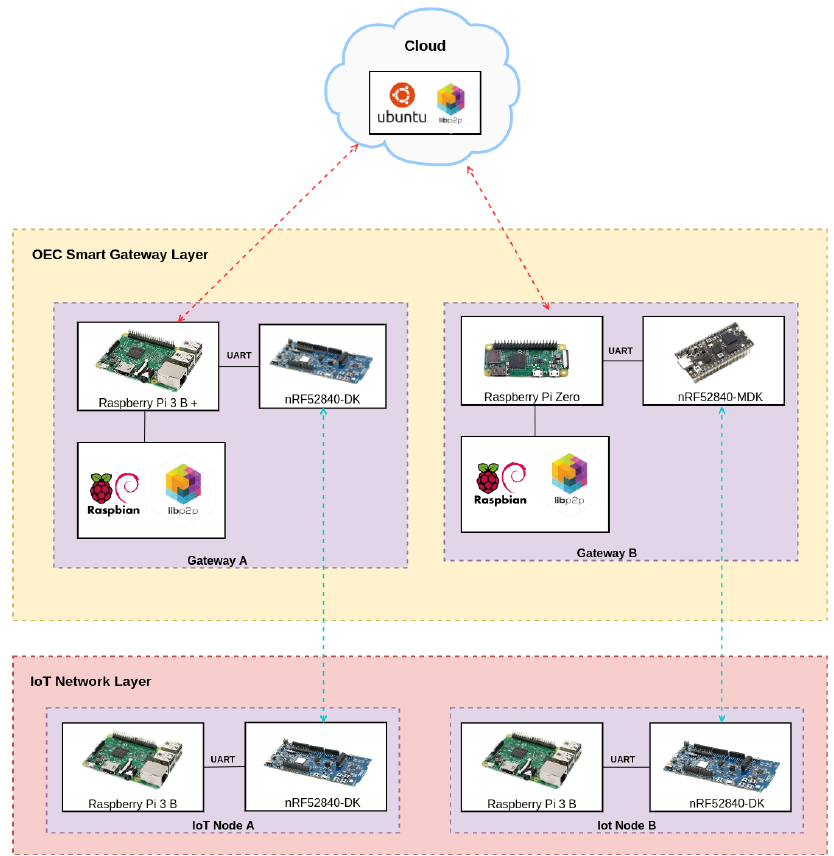
Figure 5. Experimental